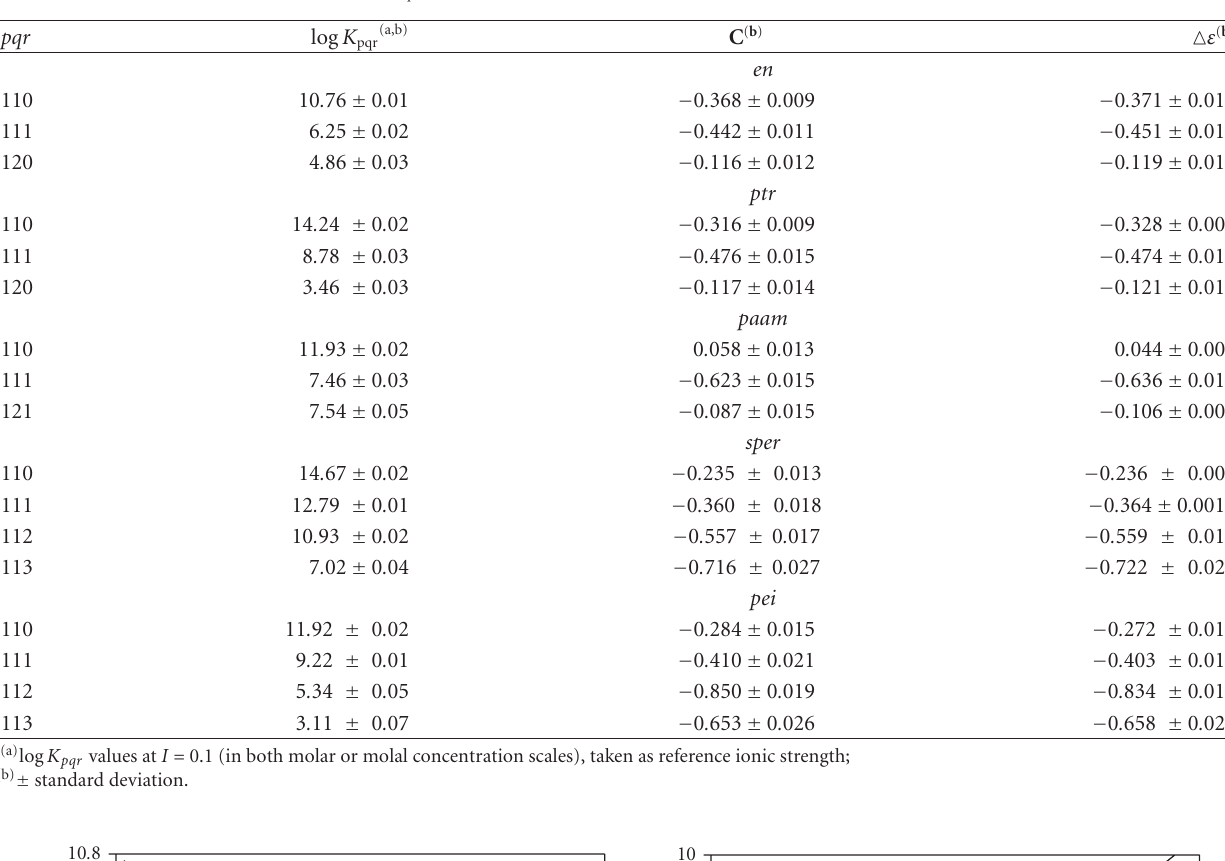
Table 4: Empirical parameters of (5) for the dependence of stability constants of dimethyltin(IV)/amine species on ionic strength in the molar or molal concentration scales, in NaCl aq and t = 25 ◦ C.